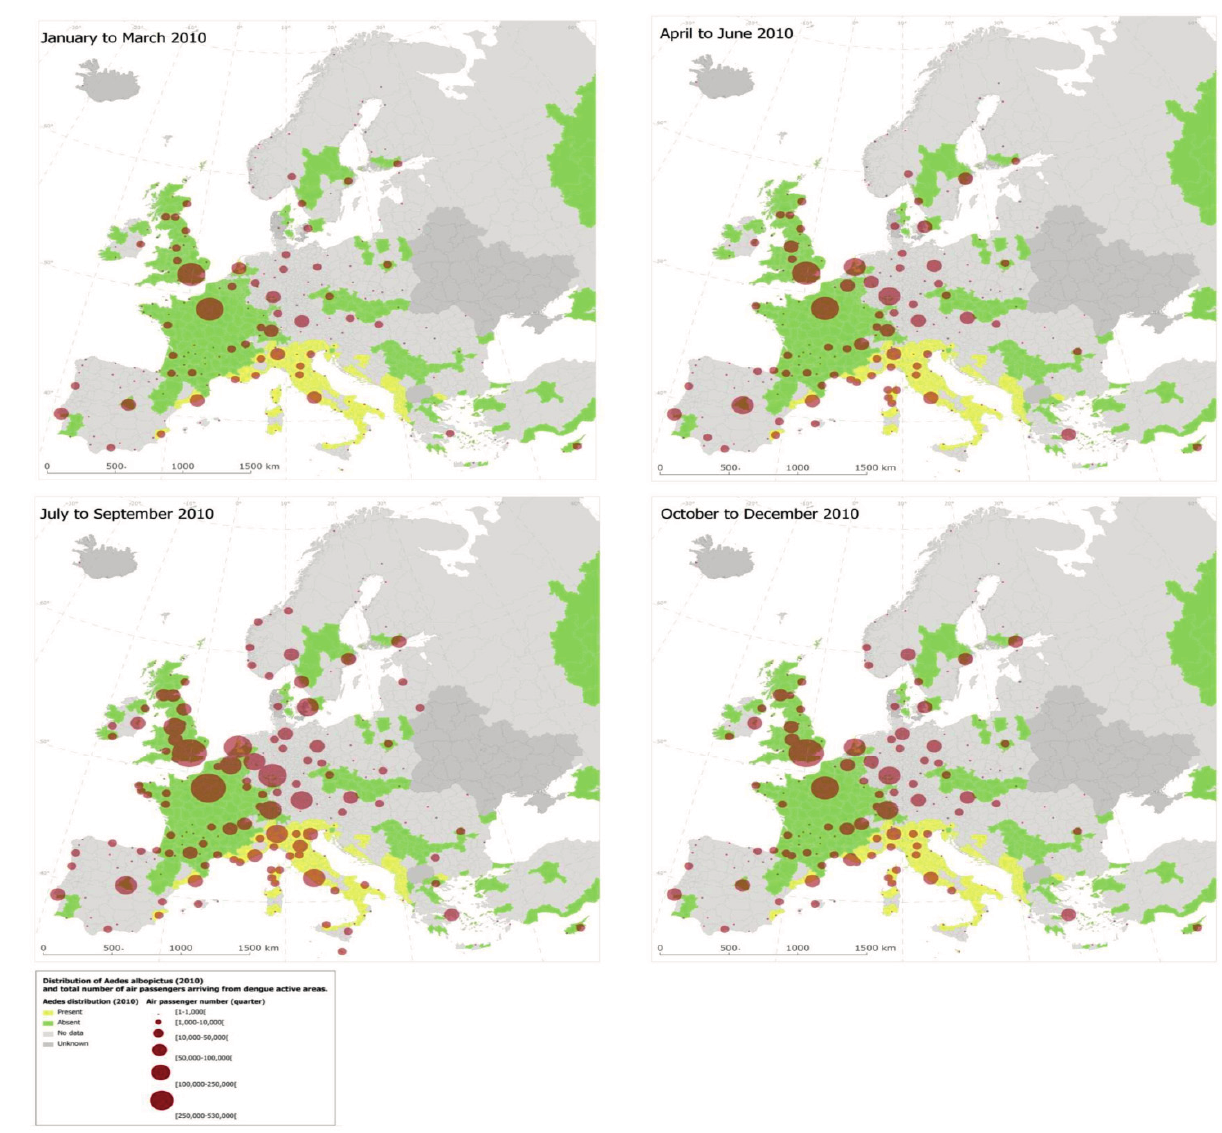
Figure 8. Airport-level final destination of international travellers from dengue affected